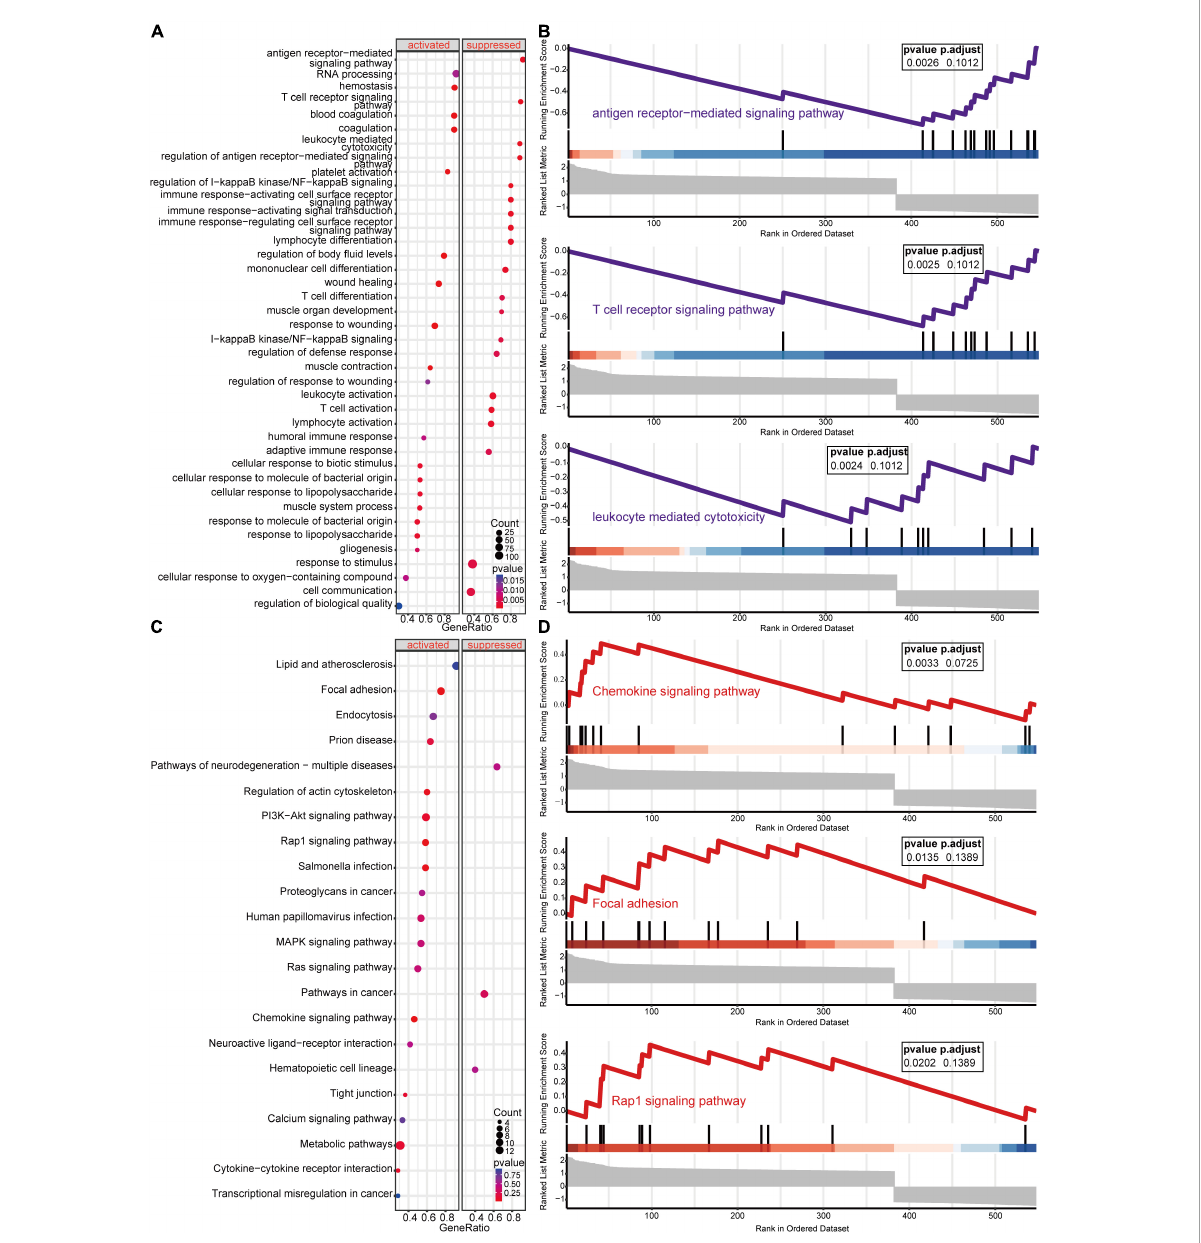
FIGURE5 Gene set enrichment analysis (GSEA) of the experimental and control groups. (A) Bubble plot of GSEA-Gene Ontology (GO) analysis results. The horizontal coordinate indicates the gene ratio, the vertical coordinate the GO terms, dot size indicates gene number, dot color the p -value, left and right separation indicate activation and repression. (B) Clustering of the first three items of GSEA-GO terms. (C) Bubble plot of GSEA-KEGG results. The horizontal coordinate indicates the gene ratio, the vertical coordinate the GO terms, dot size indicates gene number, dot color the p -value, left and right separation indicate activation and repression. (D) GSEA-KEGG analysis of the first three